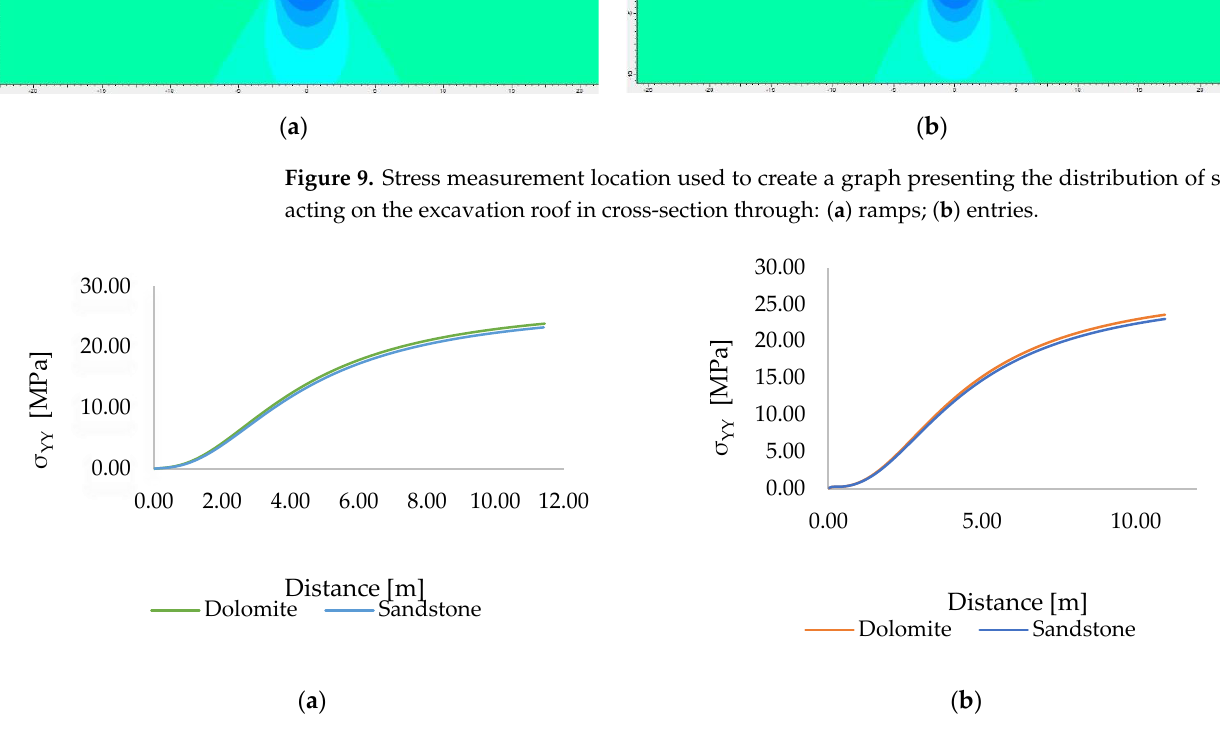
Figure 12. Distribution of σ YY stresses acting on the protective pillars in the cross-section through the ramps.